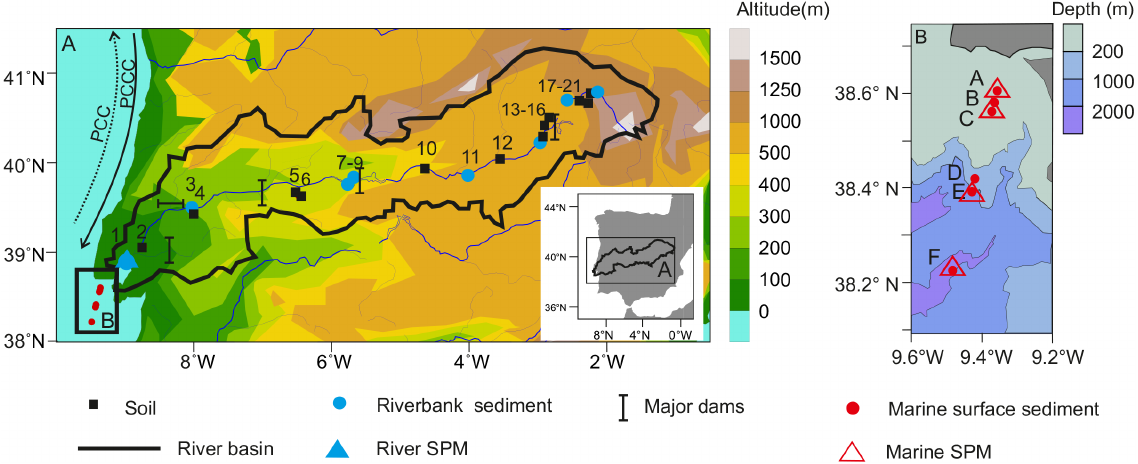
Figure 2. Overview of the study area with the sampling sites of soils, riverbank sediments, and river SPM (a) and detailed sampling locations of marine SPM and surface sediments (b) . The major dams along the Tagus River are indicated in (a) . PCC and PCCC indicate the surface currents, Portugal Coastal Current and Portugal Coastal Countercurrent,